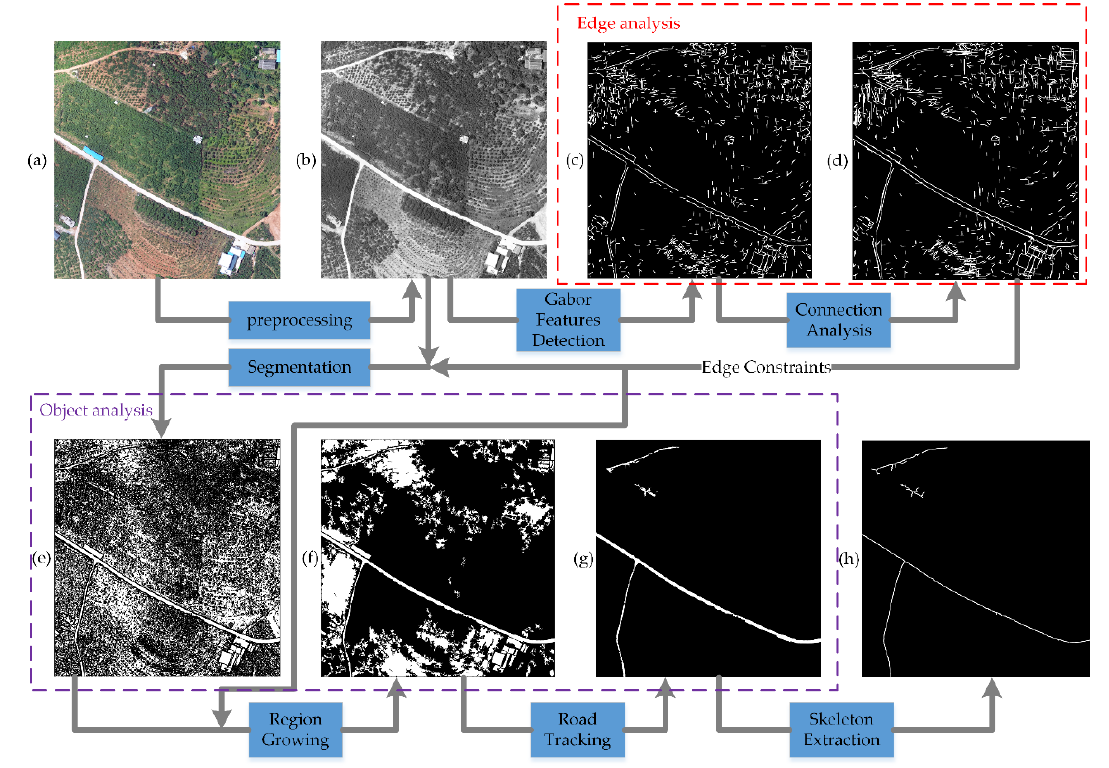
Figure 11. ( a ) Original image; ( b ) preprocessed grayscale map; ( c ) merged Gabor features in best scale; ( d ) connected Gabor features of interest; ( e ) object segmentation with edge constraints; ( f ) region-growing result; ( g ) road-object tracking by shape features; ( h ) skeleton extraction.